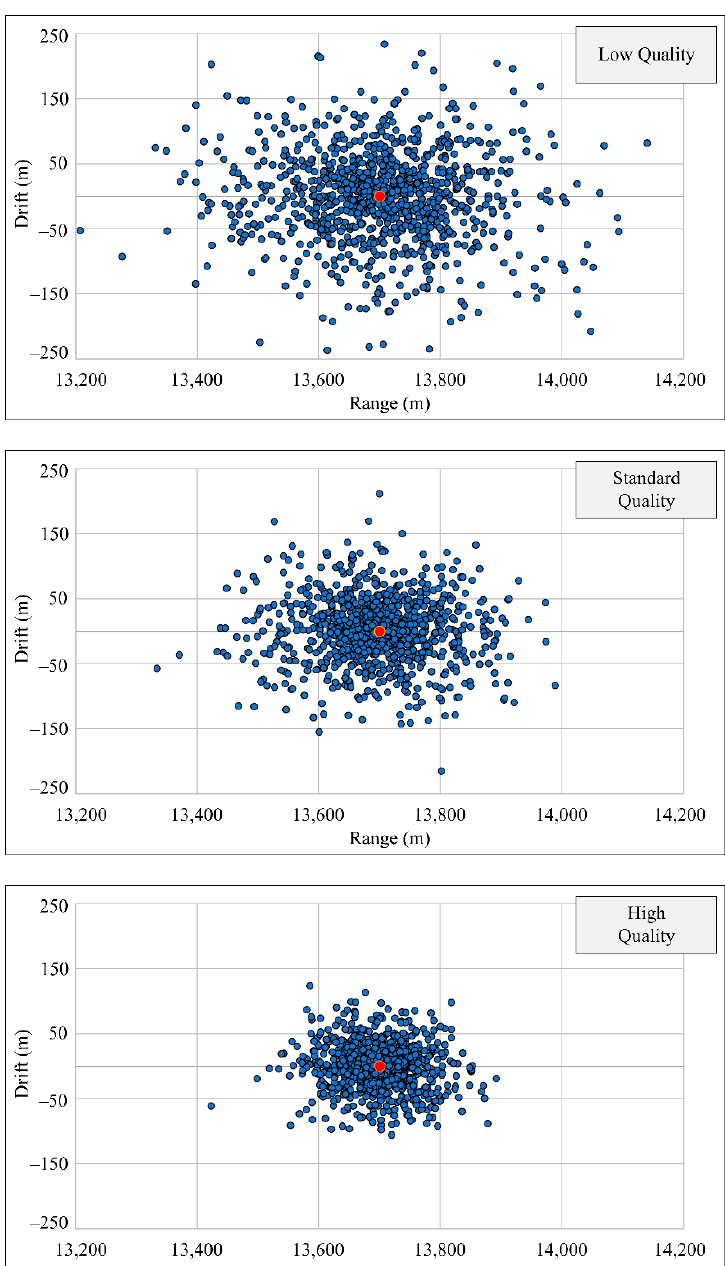
Figure 10. Rocket impact points dispersion for various quality levels.